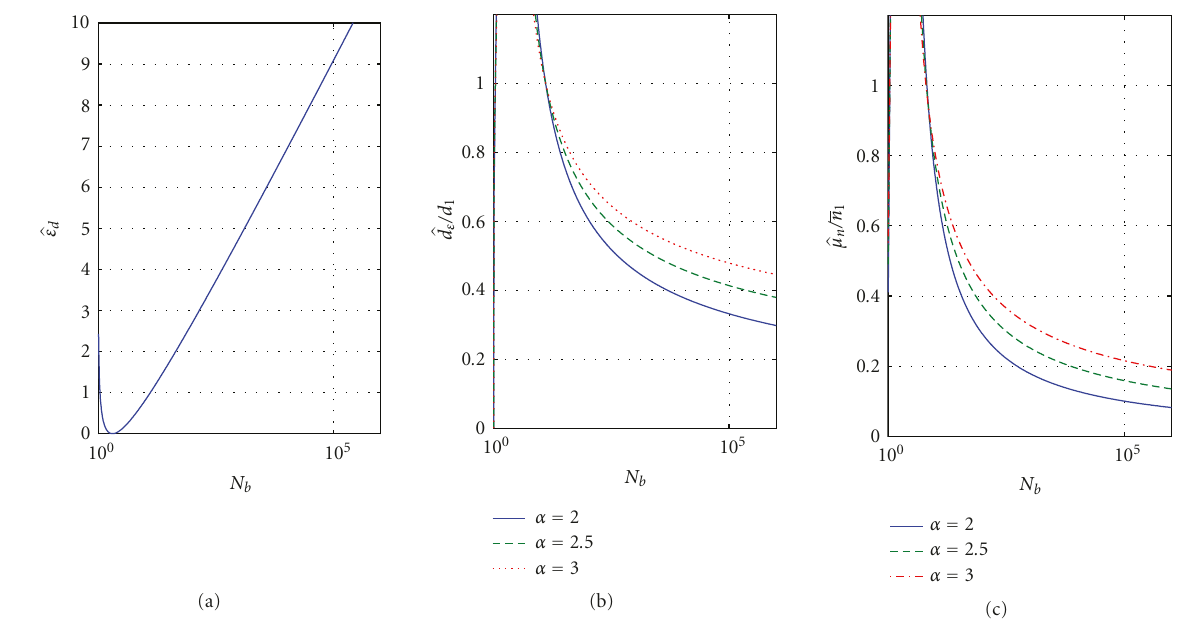
Figure 6: (a) Optimal power detection threshold as a function of frame size, (b) the corresponding range, and (c) mean node degree.